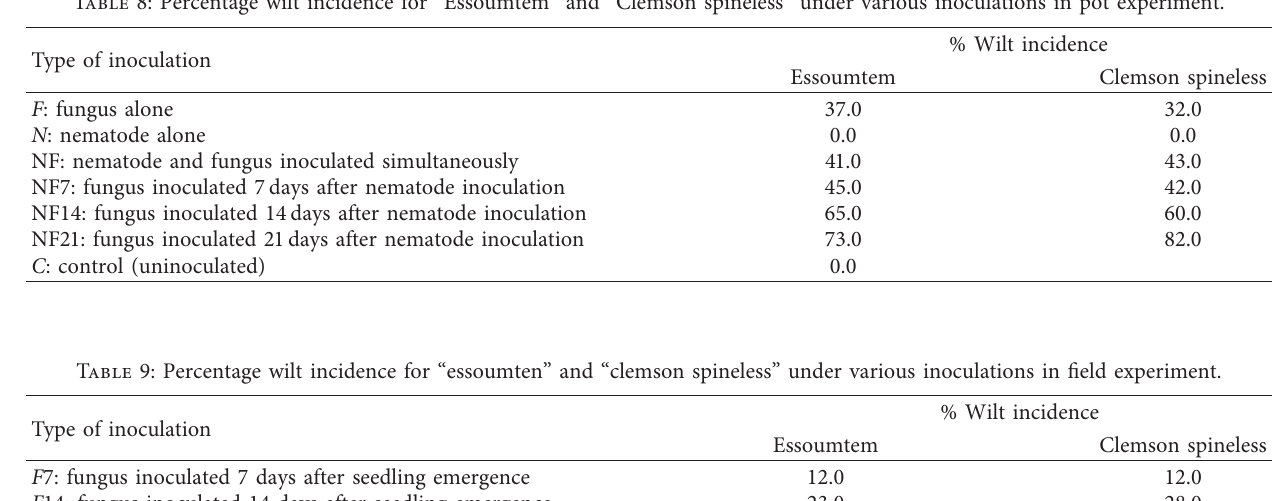
% Wilt incidence Essoumtem Clemson spineless